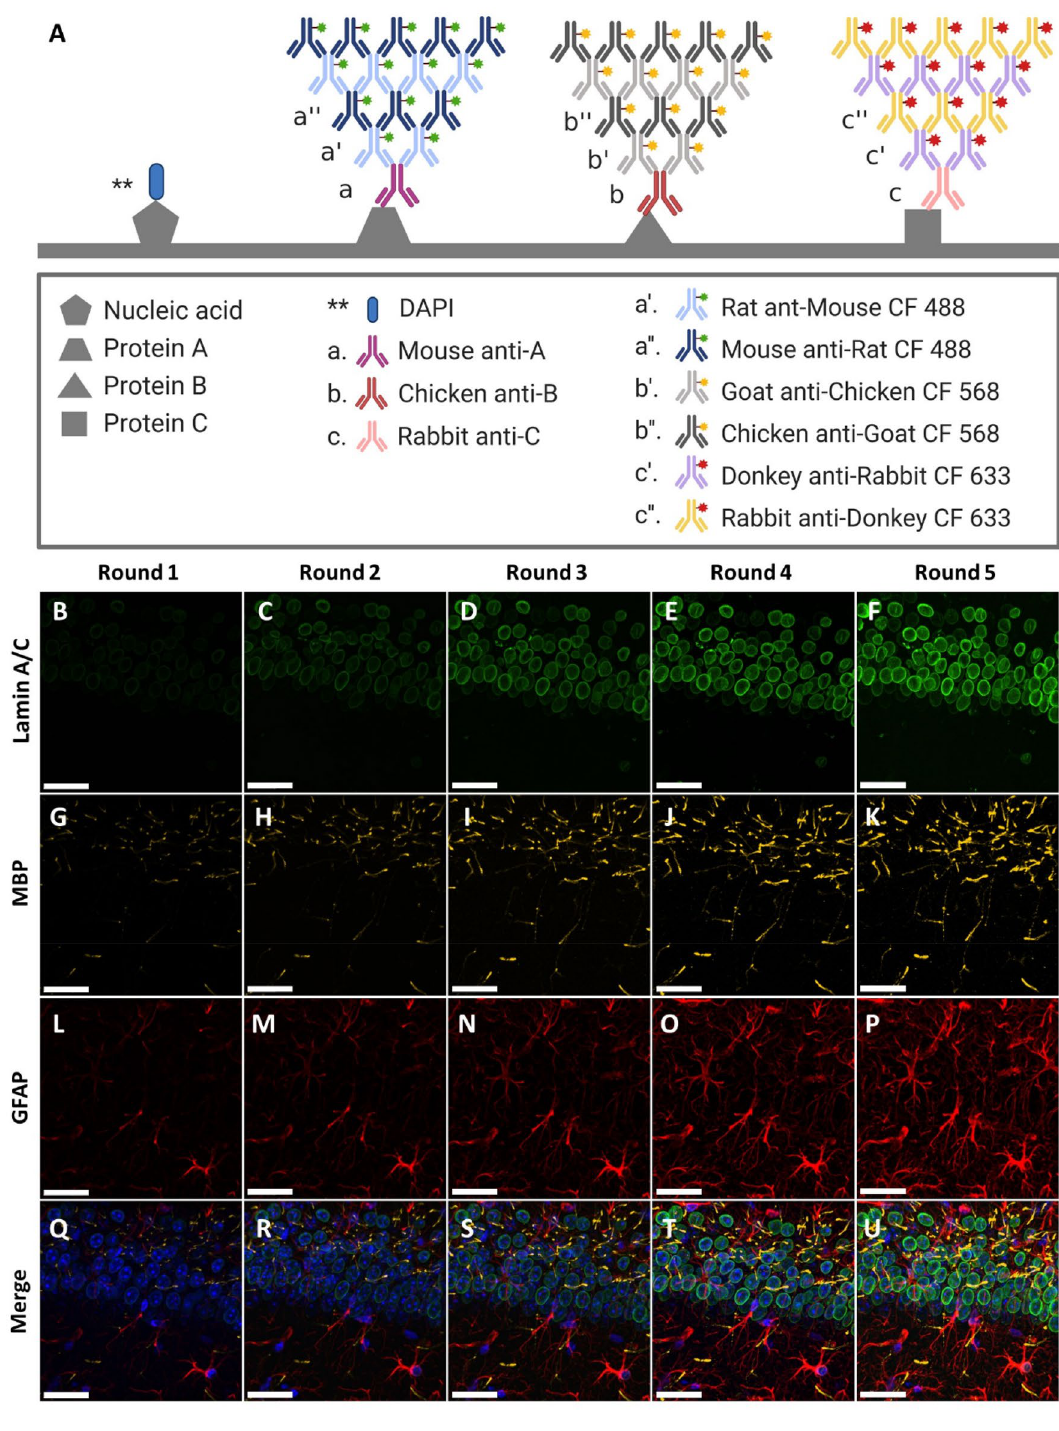
Figure 3. Simultaneous multiplexed IF signal amplification via multiplexed FRACTAL in a mouse brain slice. ( A ) Schematics of the staining process of the multiplexed FRACTAL with imaging results shown in ( B – U ). ( B )– ( U ) Multiplexed IF signal amplification imaging of the CA1 region of a mouse brain. ( B – F ) Signal amplification of lamin A/C. ( G – K ) Signal amplification of MBP. ( L – P ) Signal amplification of GFAP. ( Q – U ) Merge images of ( B – P ). ( Q ) Merge image of ( B ), ( G ), and ( L ); Round 1. ( R ) Merge image of ( C ), ( H ), and ( M ); Round 2. ( S ) Merge Image of D, I, and N; Round 3. ( T ) Merge Image of ( E ), ( J ), and ( O ); Round 4. ( U ) Merge image of ( F ), ( K ), and ( P ); Round 5. Scale bar: 30 µ